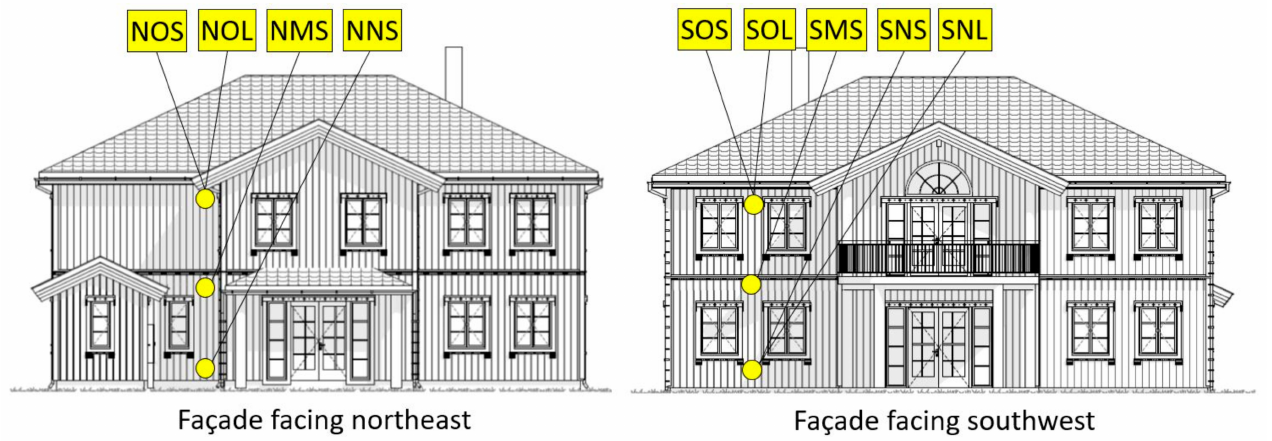
Figure 5. The sensor positions for